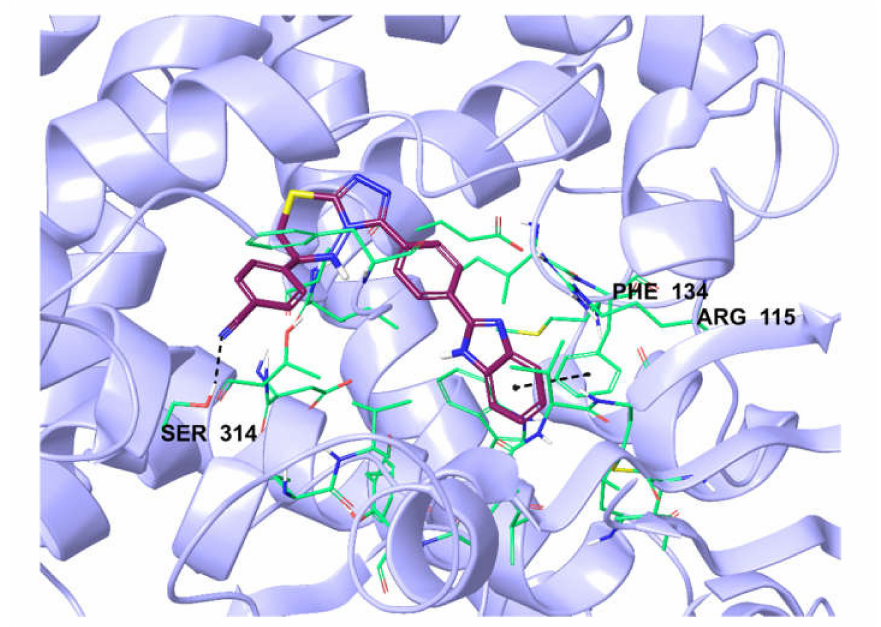
Figure 2. The interacting mode of compound 5e in the active region of human aromatase. The inhibitor, colored with maroon, and the important residues, colored with purple, in the active site of the enzyme are presented by tube model.